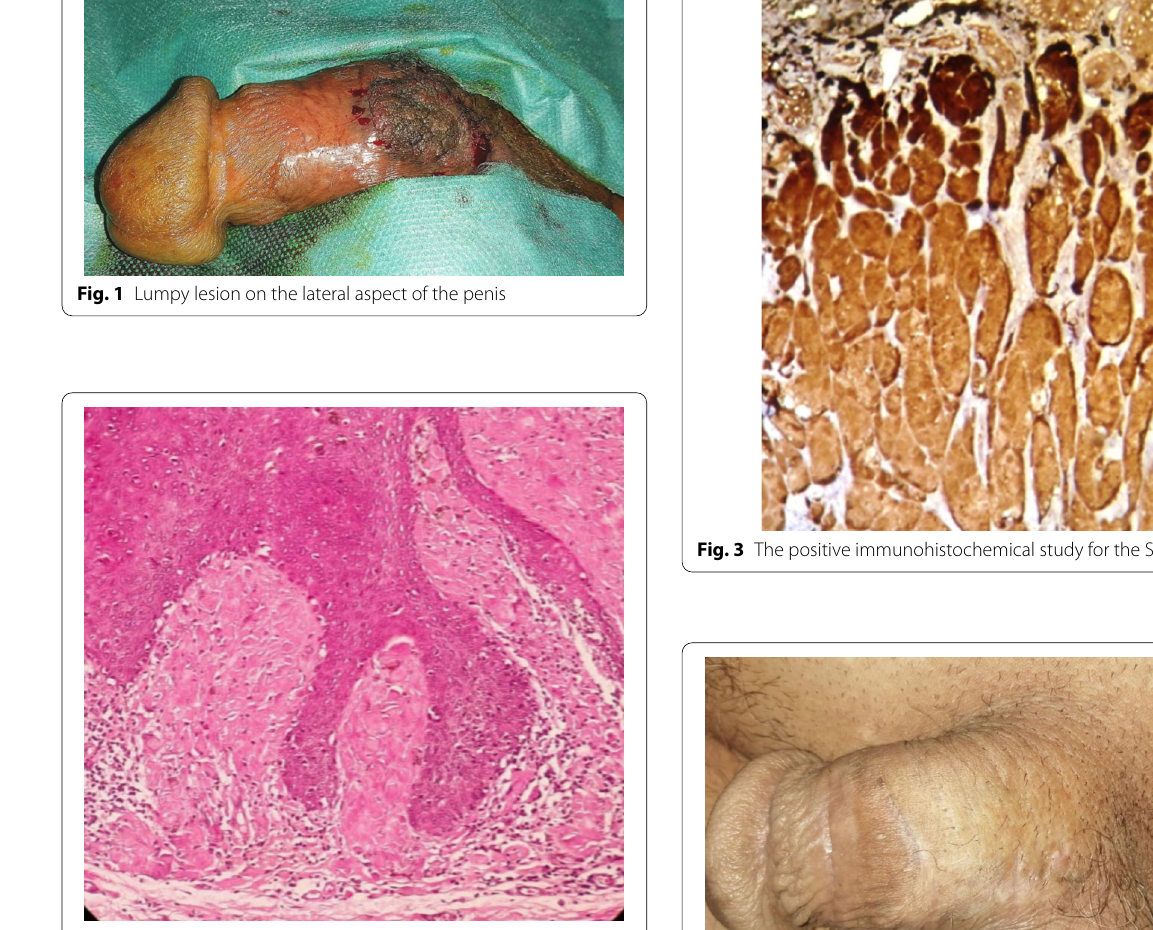
Fig. 2 Superficial dermis harbors a tumor proliferation made up of clumps of large, eosinophilic cells with a nucleus devoid of cytonuclear atypia